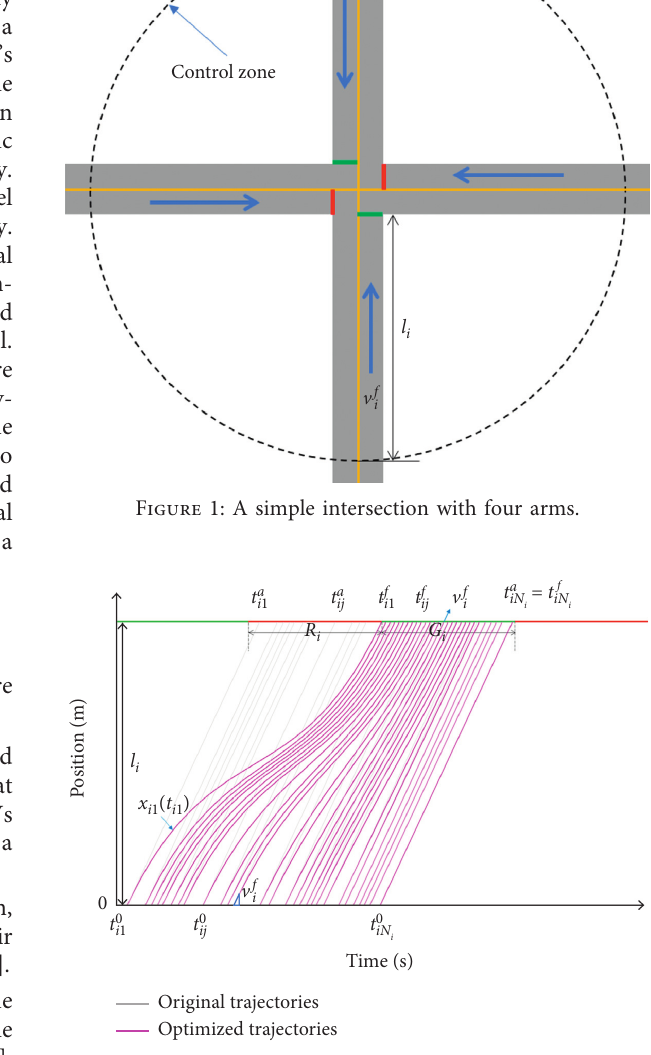
Figure 2: The vehicle trajectories planning of each arm i . i ∈ I